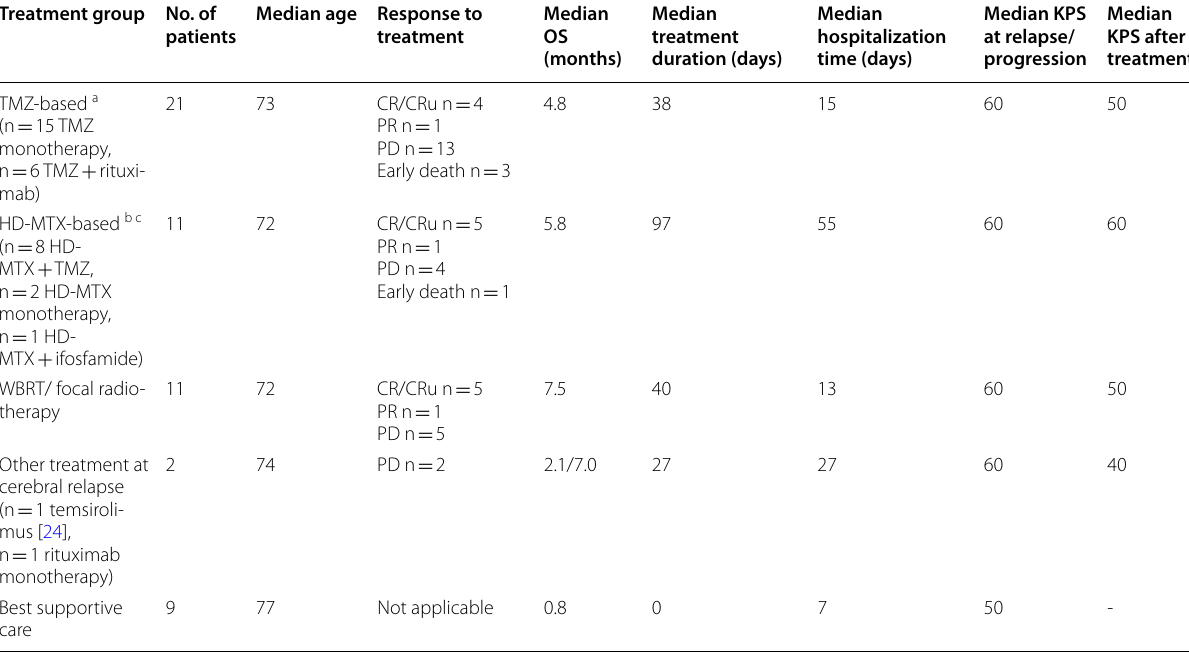
Table 3 Clinical characteristics, response to treatment, survival, treatment duration and hospitalization time after first relapse/ progression divided by treatment groups (n =